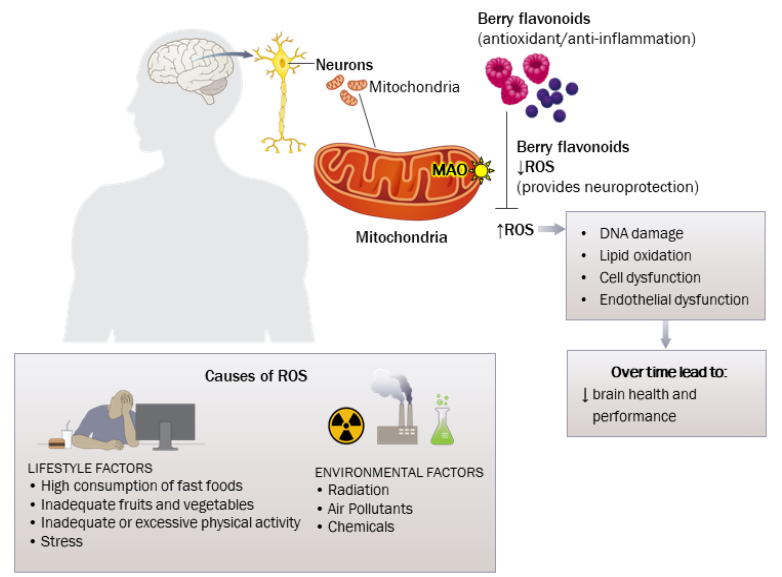
Figure 1. The Effects of Berry Flavonoids on Brain Health.